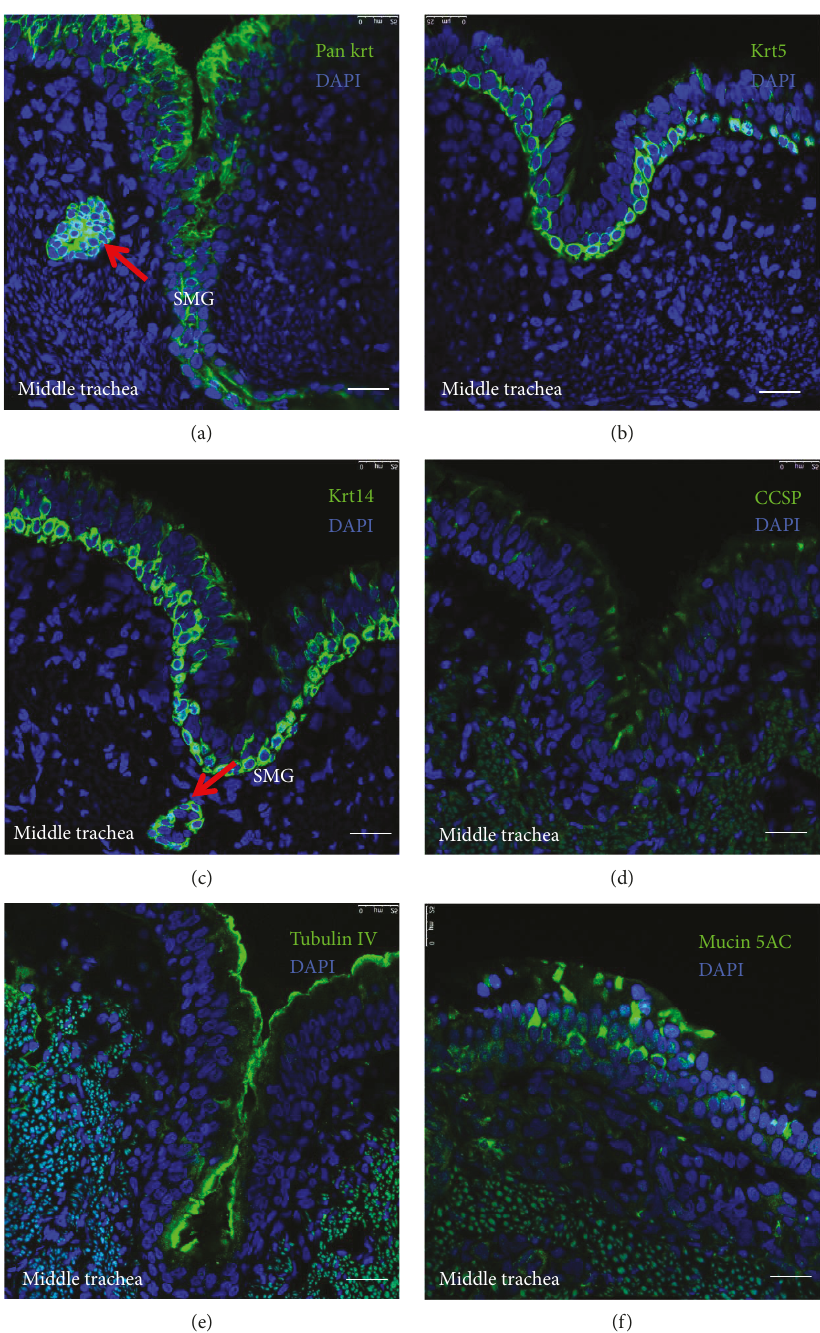
Figure 3: Immuno fl uorescence staining of epithelial cell-speci fi c markers in the middle trachea of an adult porcine lung. Representative images of immunohistochemistry (IHC) staining with epithelial cell-speci fi c markers were used for the identi fi cation of epithelial cell types in the middle trachea of an adult porcine lung. (a, b, c) Immuno fl uorescence staining for keratins of porcine tracheal epithelium, (a) pan keratin (green); (b) keratin 5 (Krt5) and (c) keratin 14 (Krt14) showed that basal cells were cuboidal-shaped and relatively short and contact the basement membrane and luminal cells. (d) Immuno fl uorescence staining for CCSP (green) revealed that infrequent cone-shaped club cells resided in the porcine tracheal epithelium. (e) Immuno fl uorescence staining for tubulin IV (green) showed the ciliated cells in the tip of epithelial layer. (f) Immuno fl uorescence staining for mucin 5AC (green) revealed that the secretory cells include morphologically and functionally distinct cells such as the goblet, serous, and club cells. Nuclear stained with DAPI (blue). Bar=50 μ